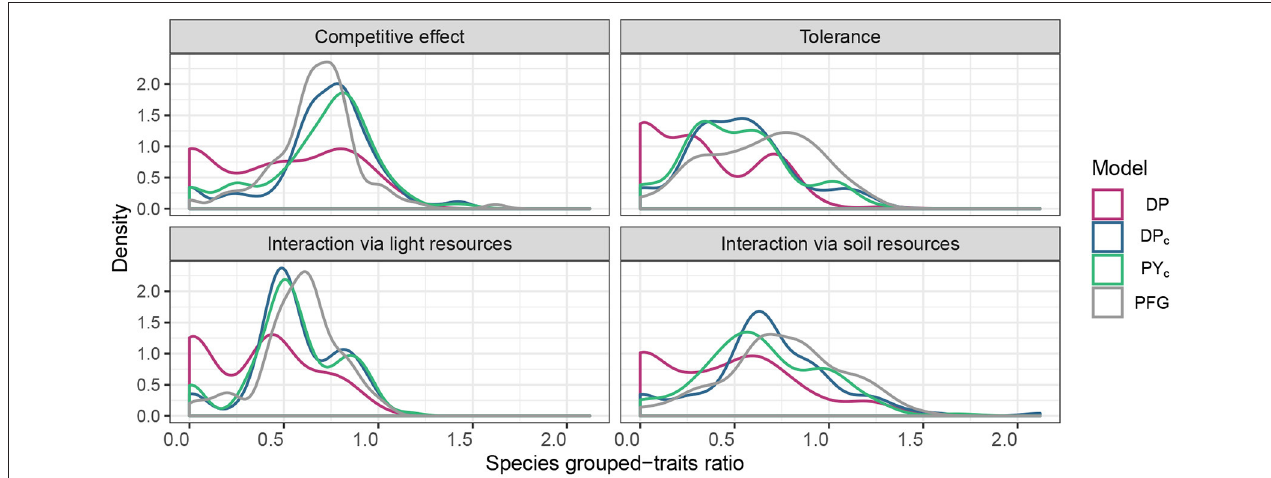
FIGURE 4 | Distribution of species grouped-trait ratio for different trait categories and for all clustering methods. The reference curve is the distribution of species grouped-trait ratio of PFGs ( DP , DP c , PY c ).